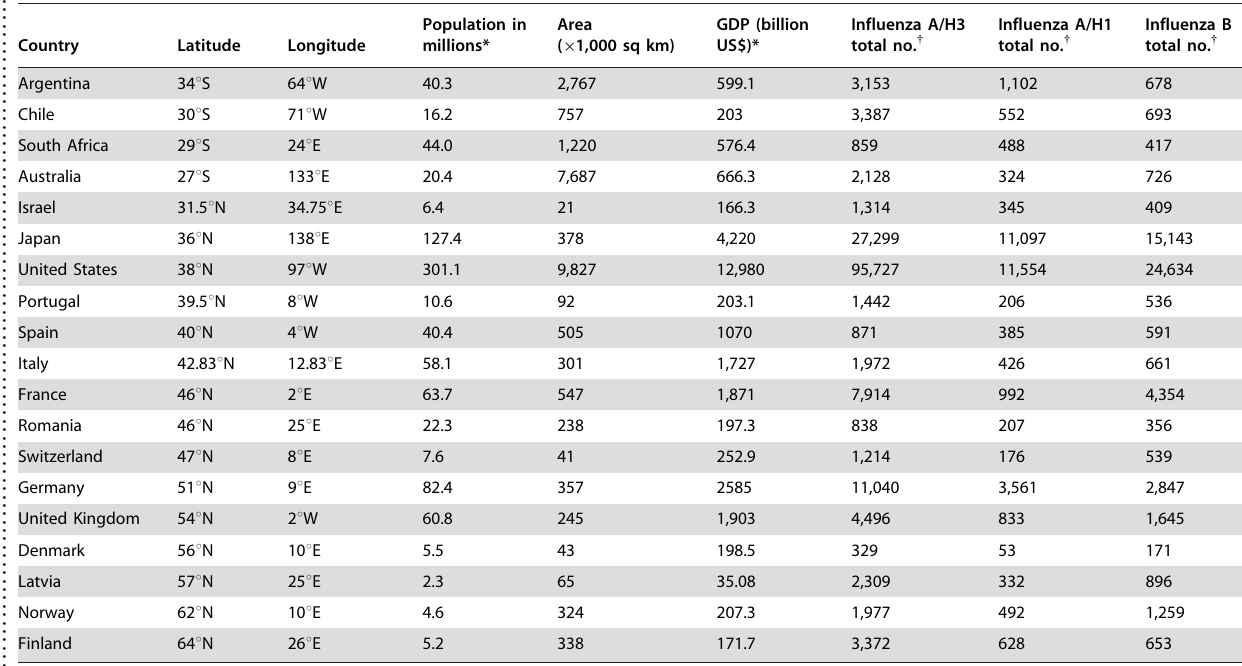
Table 1. Overall country comparisons of geography, demographics, and influenza virus surveillance data by type and subtype